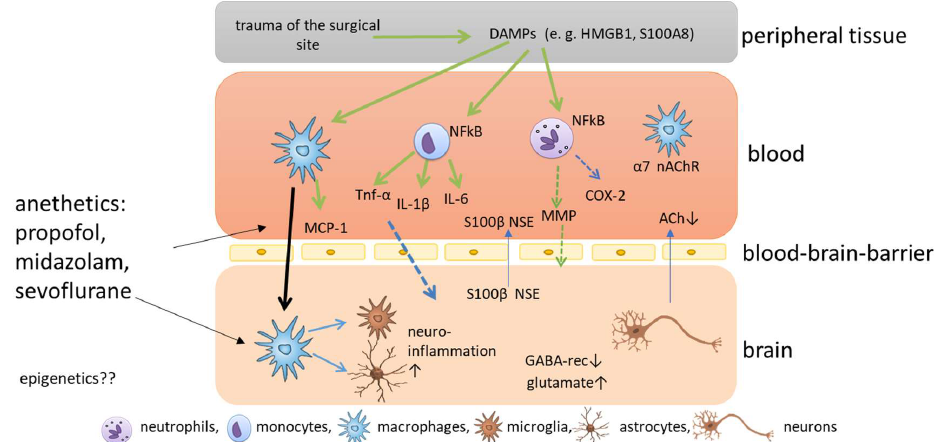
Figure 1. Schematic overview of the molecular mechanisms of postoperative cognitive impairment. Trauma of the surgical site causes the release of damage associated patterns (DAMPS), which are released into the blood where nuclear factor kappa B is activated in immune cells, such as neutrophils, monocytes and macrophages, which release cytokines and chemokines. The release of matrix metalloproteinases (MMPs) and cyclooxygenase 2 (COX2) cause permeabilization of the blood- brain barrier and pro-inflammatory cytokines and macrophages enter the brain. Here, microglia are activated and neuroinflammation is amplified.